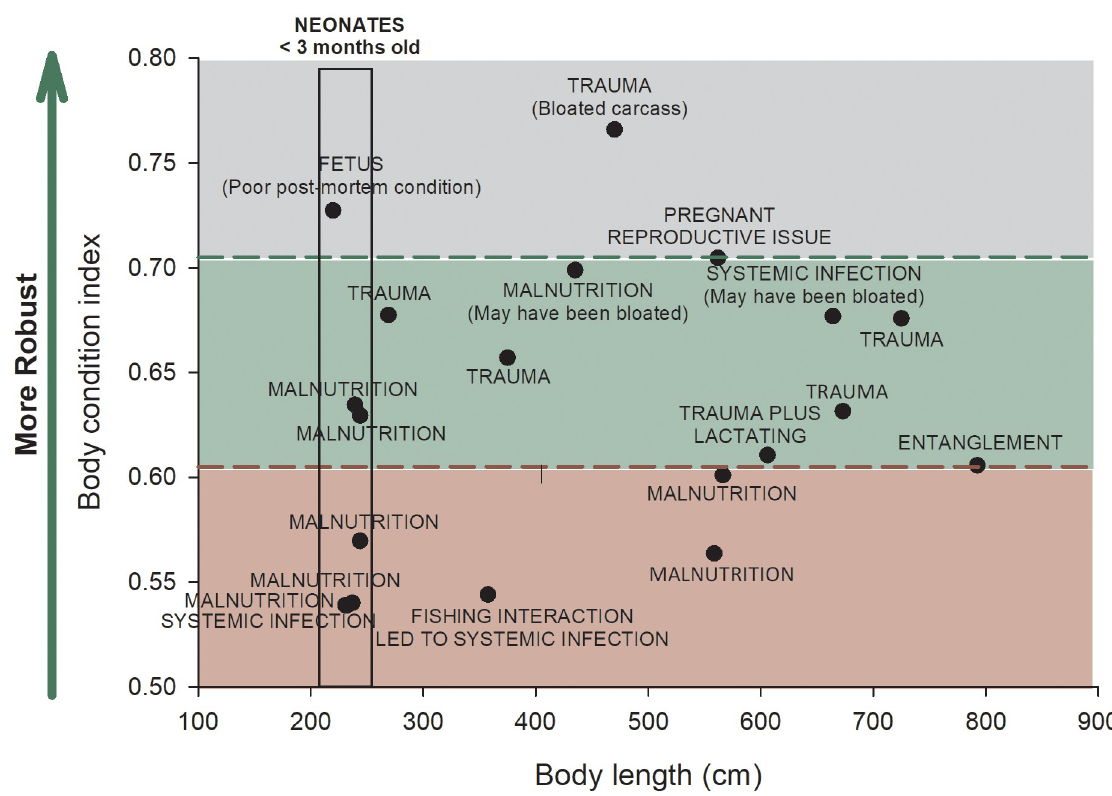
Fig 10. Relationship between body condition index, body length, and cause of mortality. BCI for killer whales with known causes of death are presented. Poor BCI (BCI, girth at the anterior insertion of the dorsal fin/body length) values, good BCI values, and artifactually inflated BCI values are designated by the red, green, and gray bands, respectively. The minimum and maximum values for the “good BCI” range (green band) are based on the minimum and 75% BCI values for animals that died from trauma. The BCI value for the pregnant female was also nearly identical to the 75% BCI value for animals that died from trauma. The animal with the greatest BCI (0.77) also died from trauma, but the necropsy report specifically states that the carcass was bloated (gray band). BCI values less than the minimum value for animals that died from trauma are considered to be in poor condition (red band). There is no relationship between BCI and body